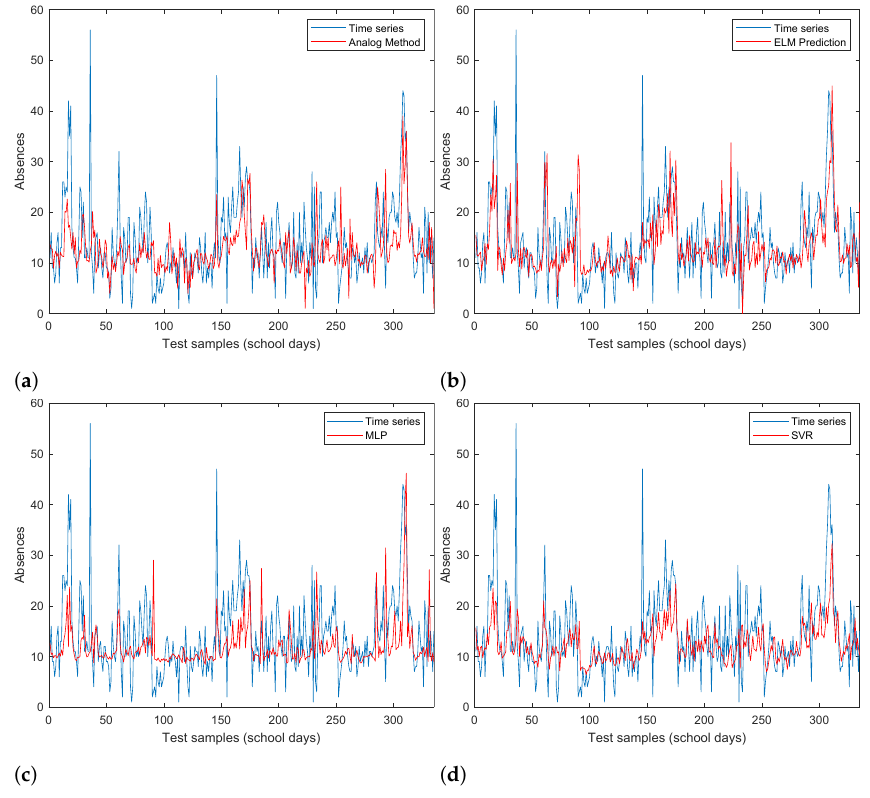
Figure 4. Performance of the different regression techniques considered in the prediction problem on over school absences dataset. ( a ) ANA; ( b ) ELM; ( c ) MLP; ( d ) SVR.